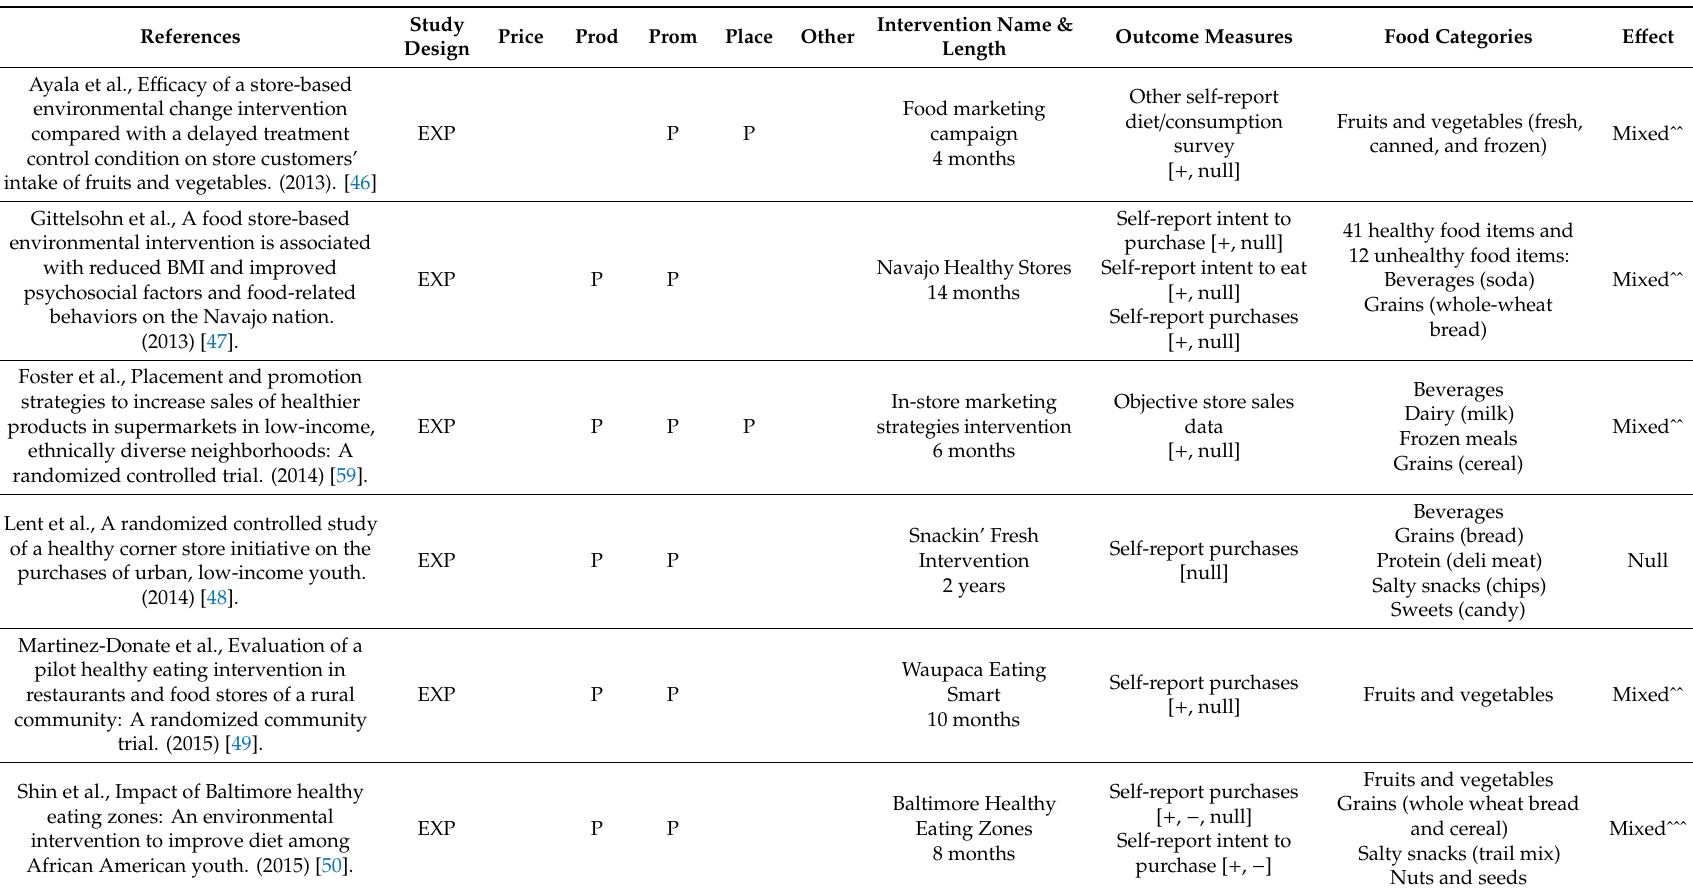
Table 3. Summary of included multi-component interventions: Design, focus, and e ff